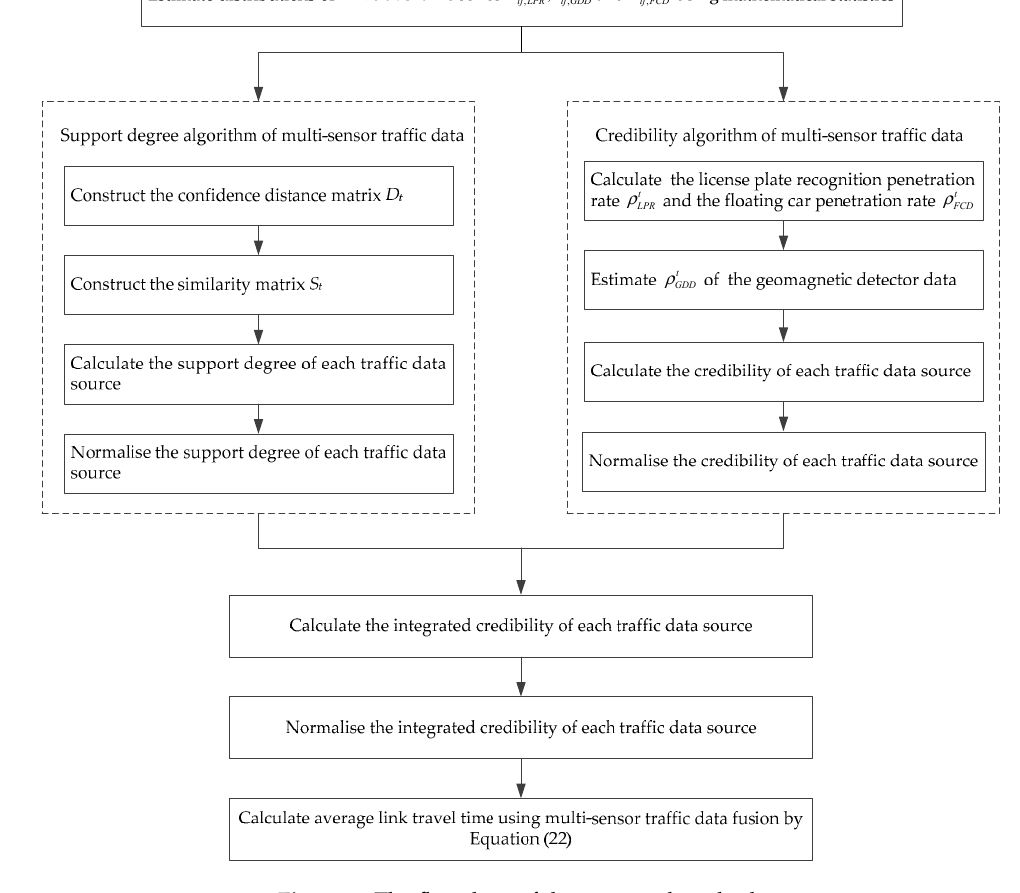
Figure 3. The flowchart of the proposed method.